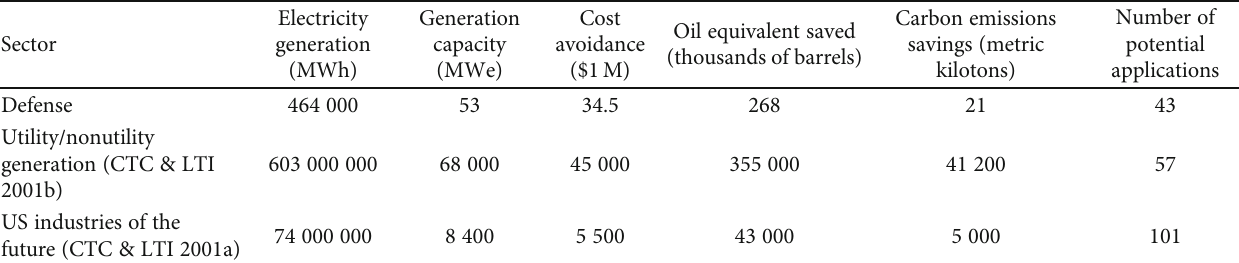
Table 2: Potential annual bene fi ts of thermoelectric device application (adapted from